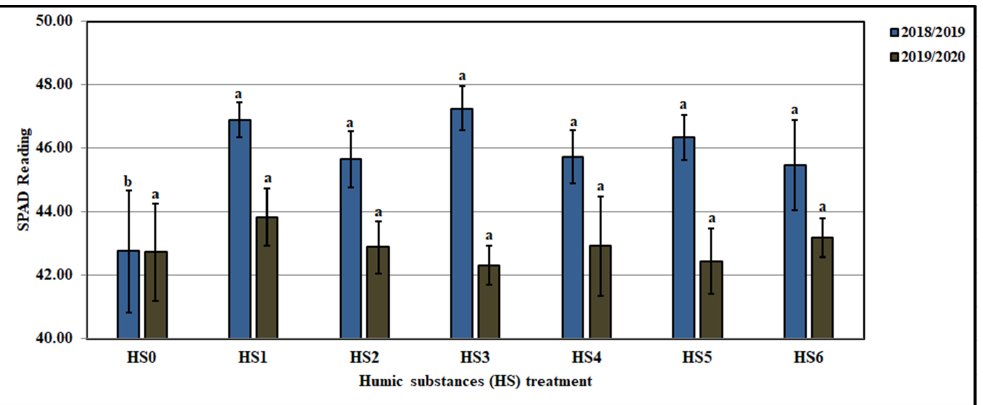
Figure 2. Influence of humic substances treatments on leaf area (LA, cm) of some wheat varieties grown in clay loam soil in 2018/2019 and 2019/2020 seasons. Bars in the same years with a different letter indicate significant differences between treatments at p ≤ 0.01. HS 1, HS 2 , HS 3 represent HS applied as foliar spray at 1.0, 2.0, 4.0 g L − 1 , respectively, HS 4 , HS 5 , HS 6 represent HS applied as soil application at 5.04, 7.56, 10.08 kg ha − 1 .